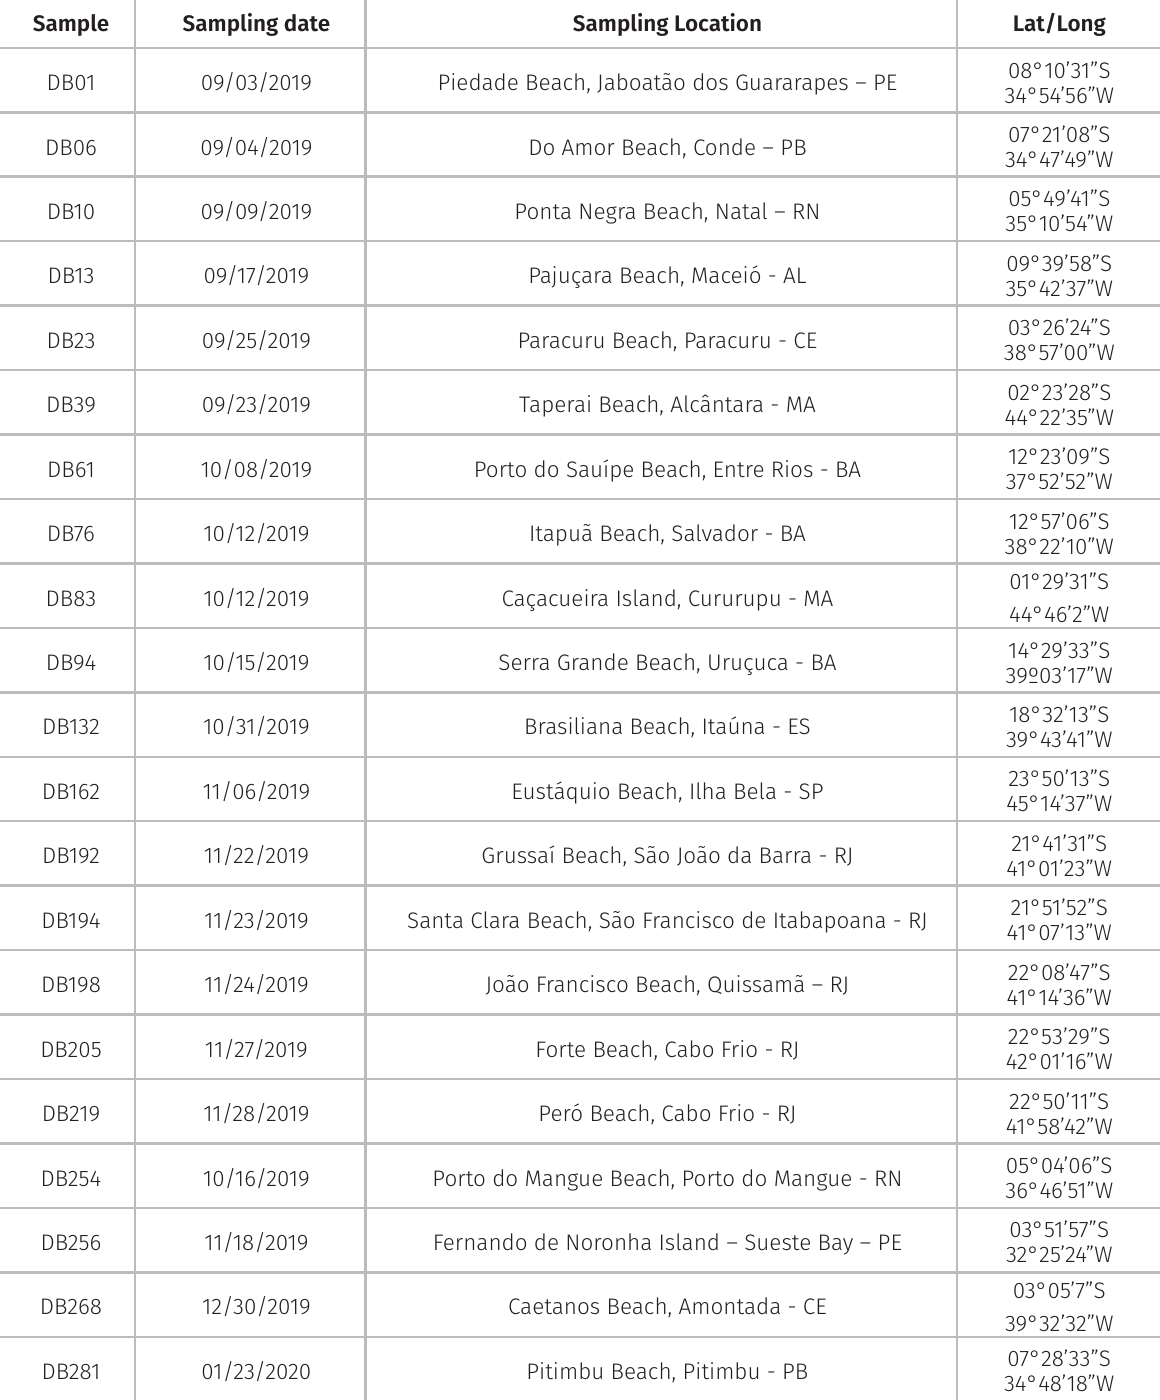
Table I. Samples considered for this